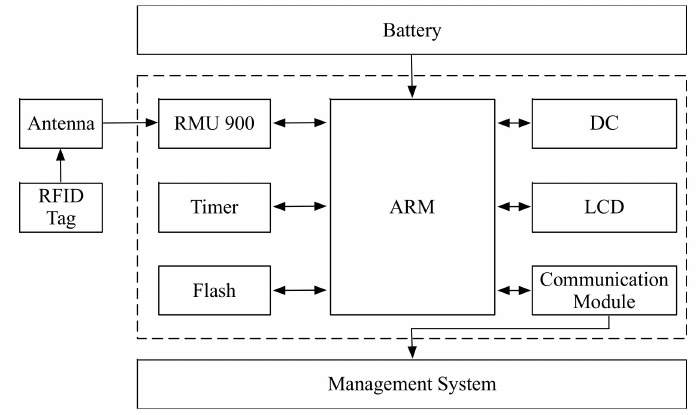
Figure 5. The architecture of digital key in the RFID lock